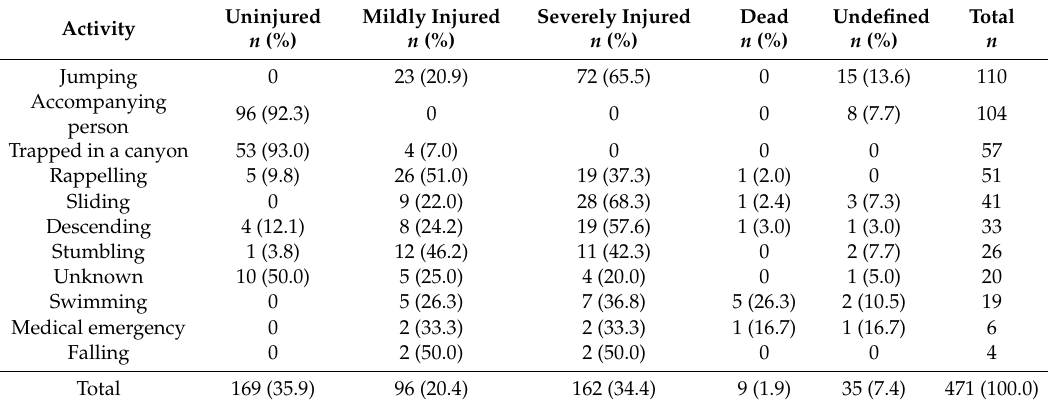
Table 2. Activity leading to di ff erent severity grades of injuries in canyoning emergencies in Austria from November 1, 2005 to October 31,